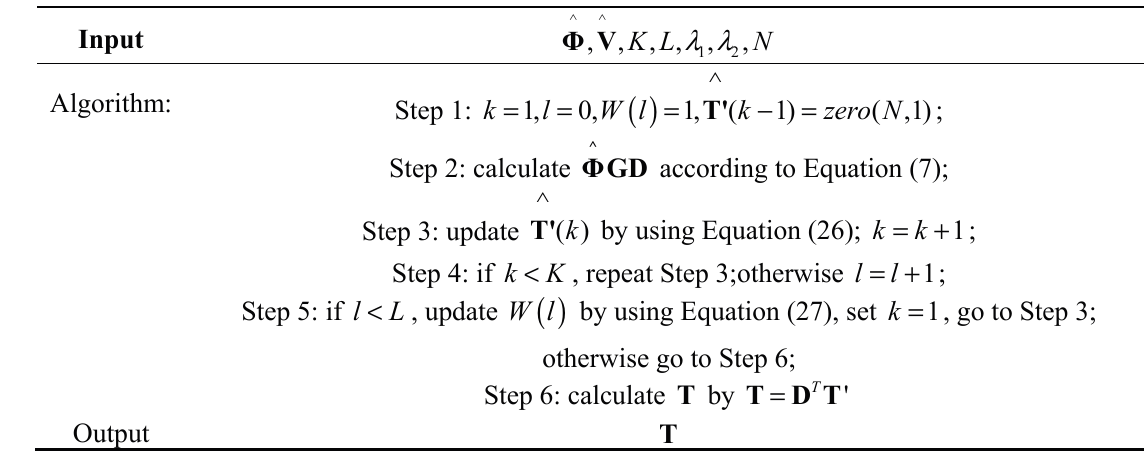
Table 1. The main simulation parameters of